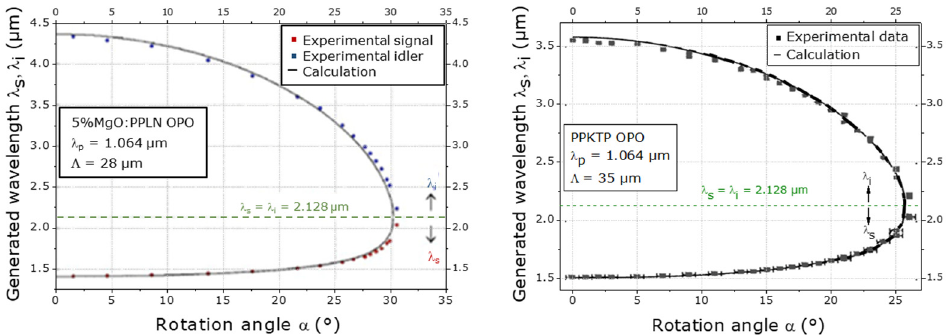
Figure 14. Tuning curves of AQPM OPO pumped at λ p = 1.064 µm, giving the signal ( λ s ) and idler ( λ i ) wavelengths as a function of the rotation angle α of the cylinders of 5%MgO:PPLN ( left ) and PPKTP ( right ).